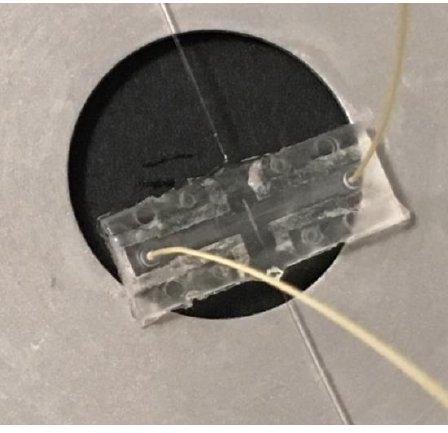
Figure 9 . Picture of the final plastic optical stretcher with the PEEK tubes (yellow) and optical fibre inserted in it.